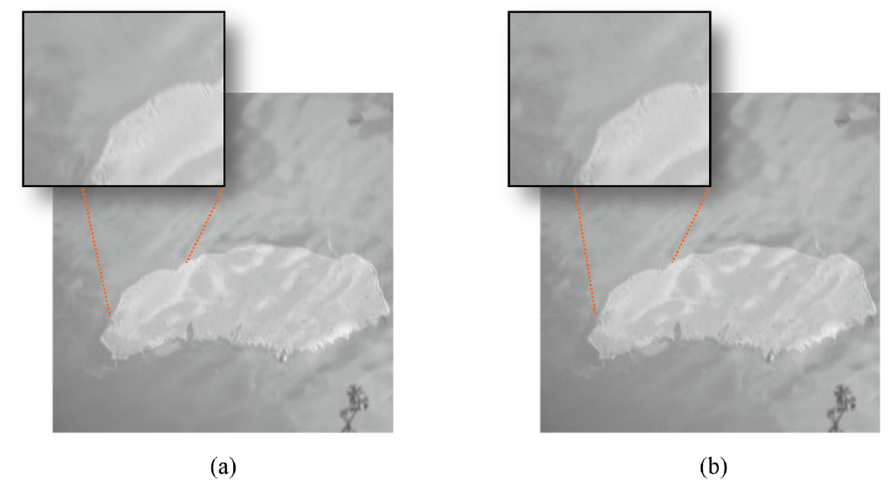
Figure 3. An example of the pre-segmentation processing—( a ) original image (4000 × 4000) and ( b ) processed image (500 × 500).